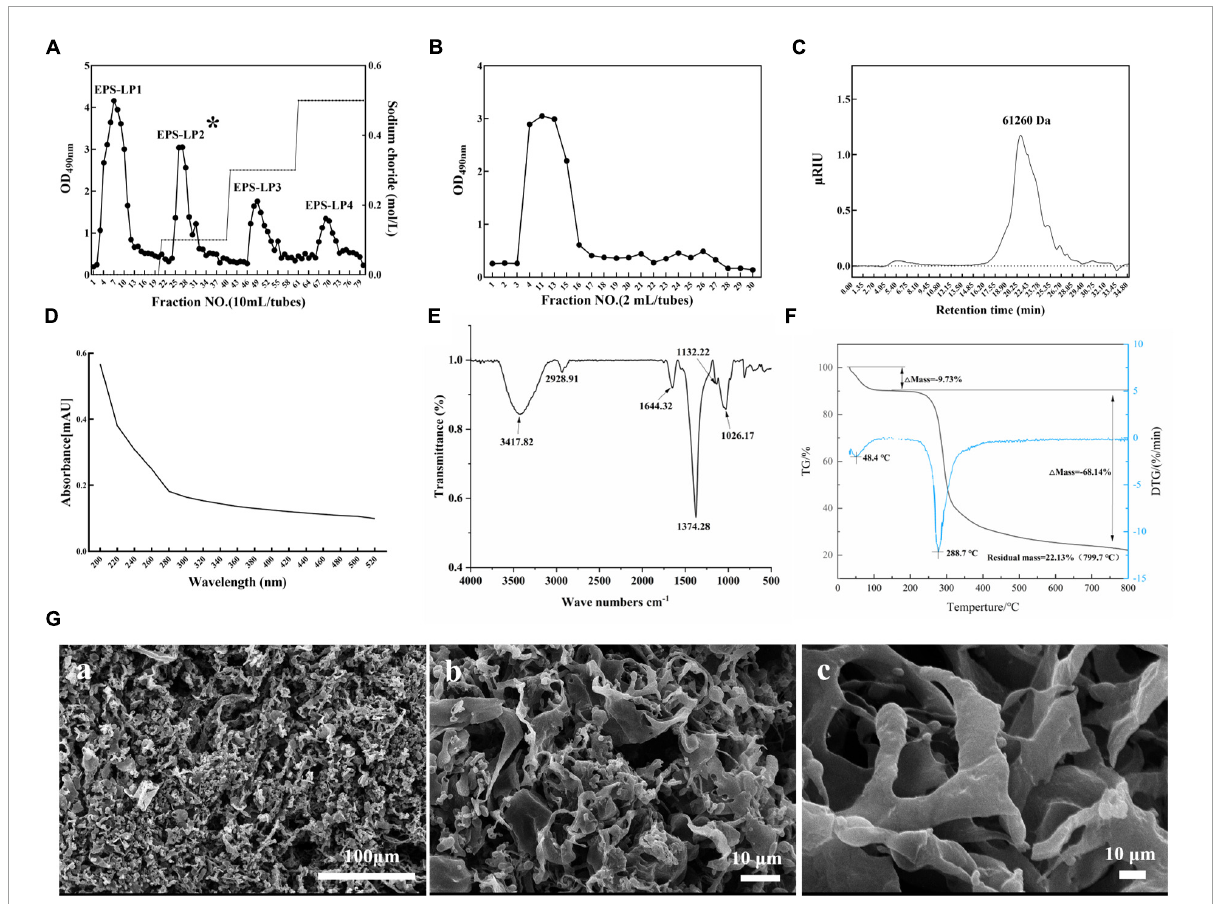
FIGURE2 Production, separation, purification, and general properties analysis of exopolysaccharides (EPS)-LP2 from LP9010. (A) Chromatograms of EPS purified by DEAE cellulose-52 anion exchange column and (B) Sephadex G-75 column, (C) high-performance gel permeation